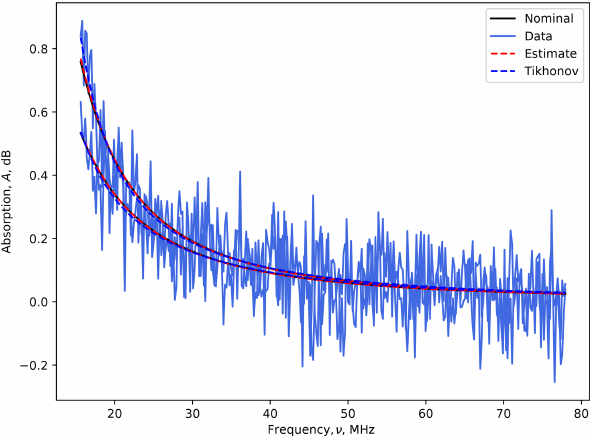
Figure 9. Residuals between data from original and determined models. The solid line corresponds to the o mode, and the dashed line is for the x mode. All four methods give the same result for the given mode. The lines are superimposed, which is why only one colour seemingly appears, even though all methods are being plot- ted, as per the legend.